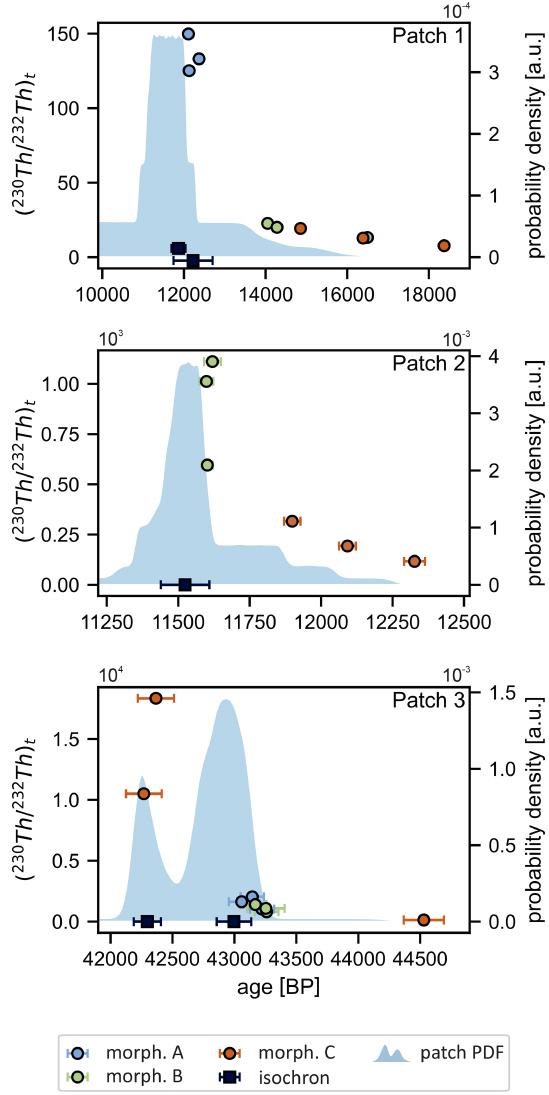
Figure 3. Uncorrected ages plotted against the respective ( 230 Th / 232 Th) t ratios. Colour represents morphology type. Also shown for each patch are corresponding isochron ages ( ± 95% con- fidence interval) and the summed normalised probability density functions (PDFs) calculated from an array of ( 230 Th / 232 Th) 0 val- ues. Samples of type A in patch 2, which are much older, are not shown to allow better scaling.